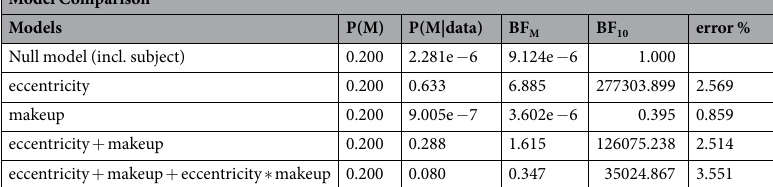
Table 3. Model comparison for Experiment 3A. Note . All models include